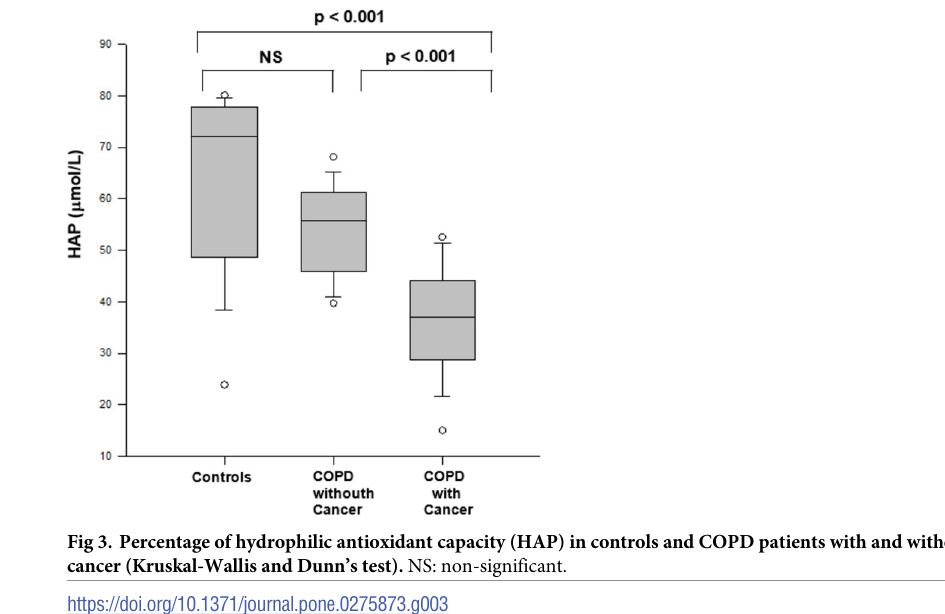
Table 2. Predictors of lipid peroxidation, antioxidant capacity, and DNA damage. Dependent variable MDA (R 2 = 0.26)